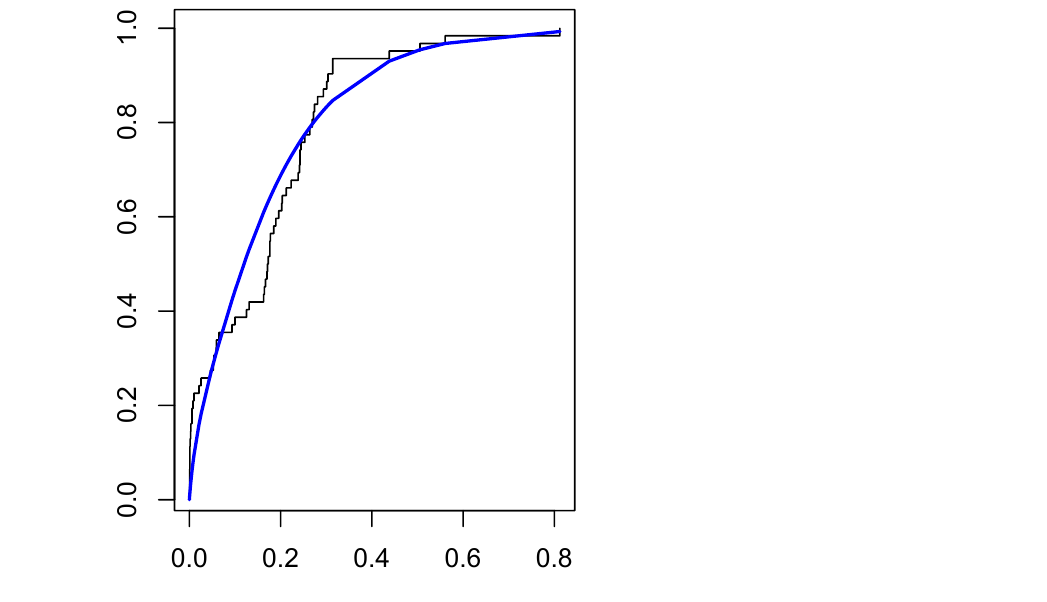
Figure 8. Empirical (black) and fitted EHPE (blue) cdf for the incidence rate of COVID-19 in dataset